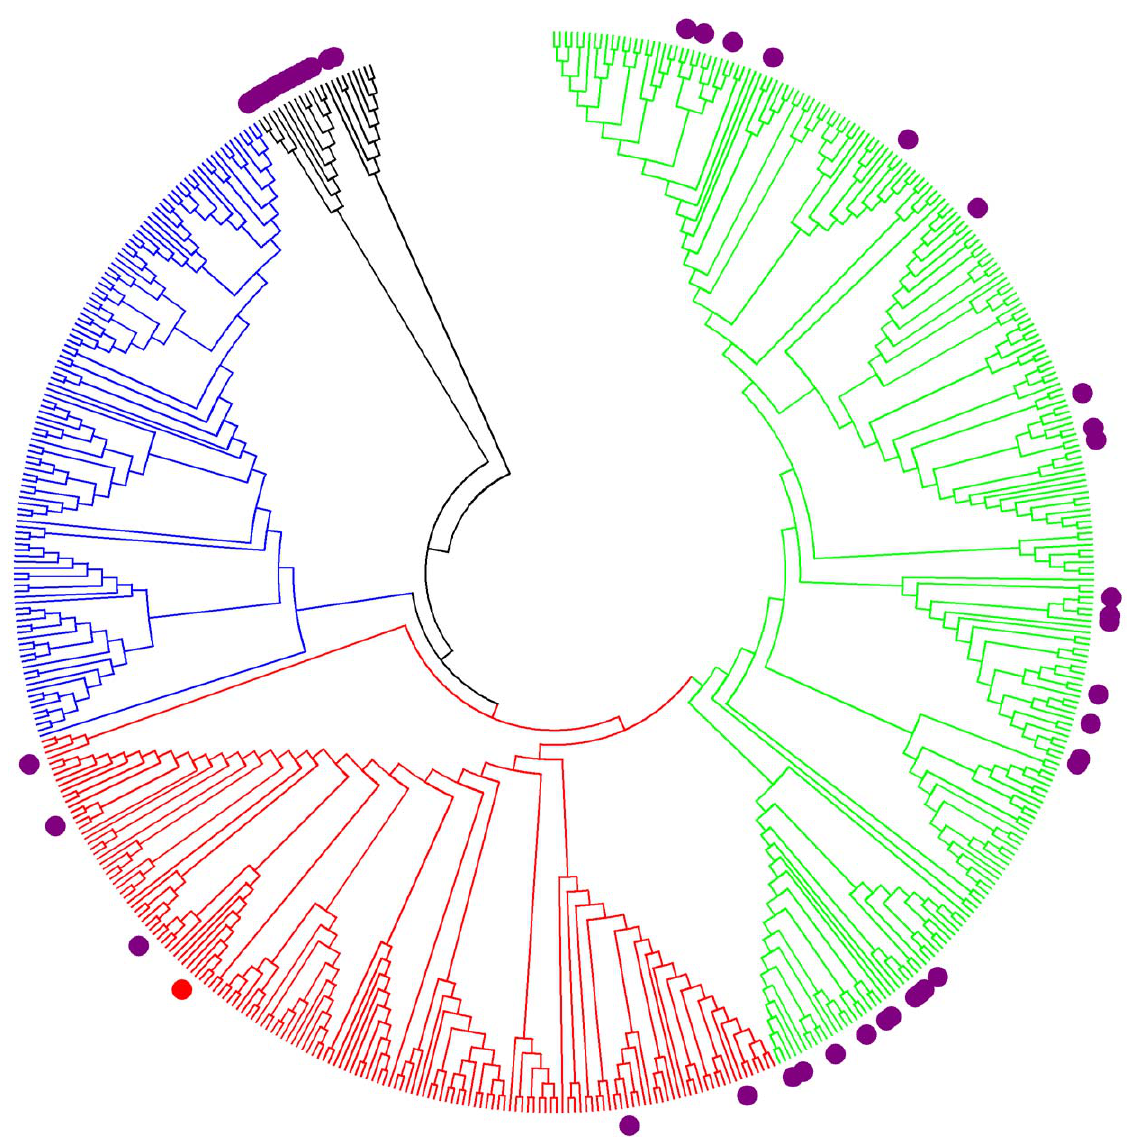
Figure 5. Phylogeny of B.cereus Sequence Types. The evolutionary history of all the B. cereus MLST concatenated Sequence Types (545 taxa, 2,394 nucleotide positions) was inferred using the Neighbor-Joining method [28]. The bootstrap consensus tree inferred from 100 replicates was taken to represent the evolutionary history of the taxa. Evolutionary Distances were computed using the Maximum Composite Likelihood method [15] and are in the units of number of base substitutions per site. The tree was rooted at ST83 ( B. pseudomycoides ) and clade designations were based on the presence of STs identified by Barker et al [29]. Clade 1 branches are shown in red, clade 2 in green, clade 3 in blue and outgroup strains in black. The Rockville STs are shown as purple circles. For reference, B. anthracis (ST1) is shown as a red circle.